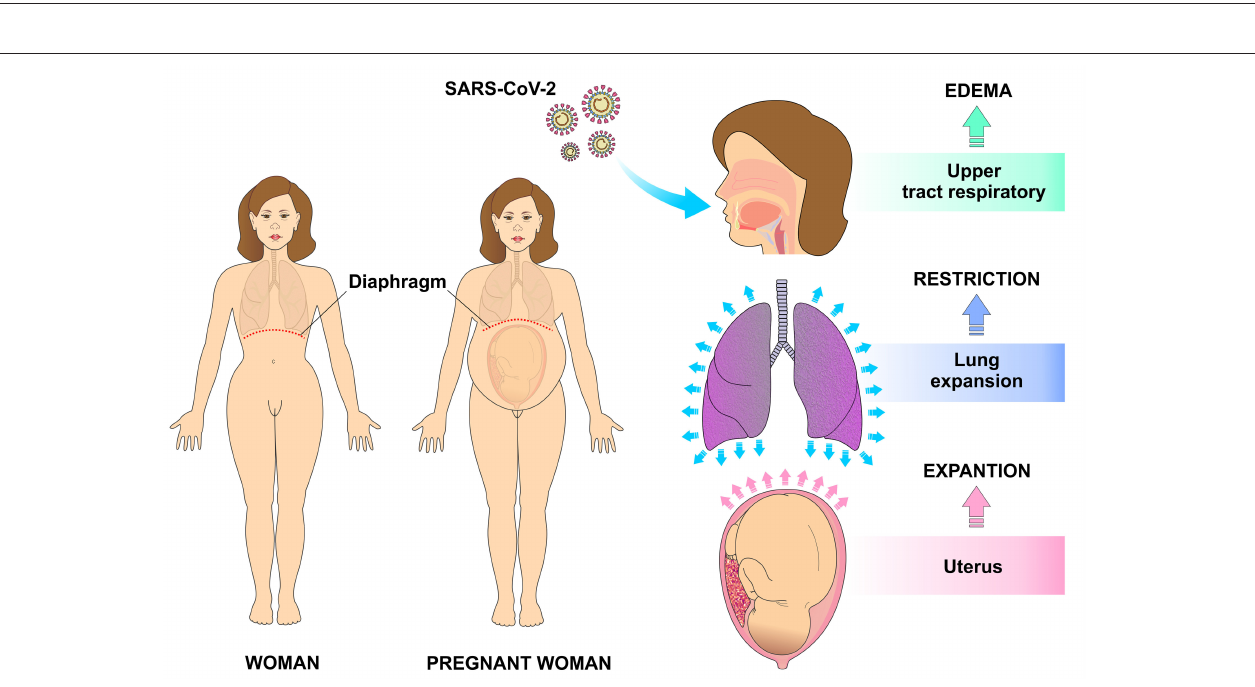
FIGURE 1 | Transmission mechanism of SARS-CoV-2 by air. Infected children, adults, and elderly disseminate viral particles by sneezing or coughing. Upon reaching the mucosa of the upper airways or alveoli, the SARS-CoV-2 viral particles bind to specific receptors on the cell surface and initiate the process of cell penetration and subsequent viral replication.